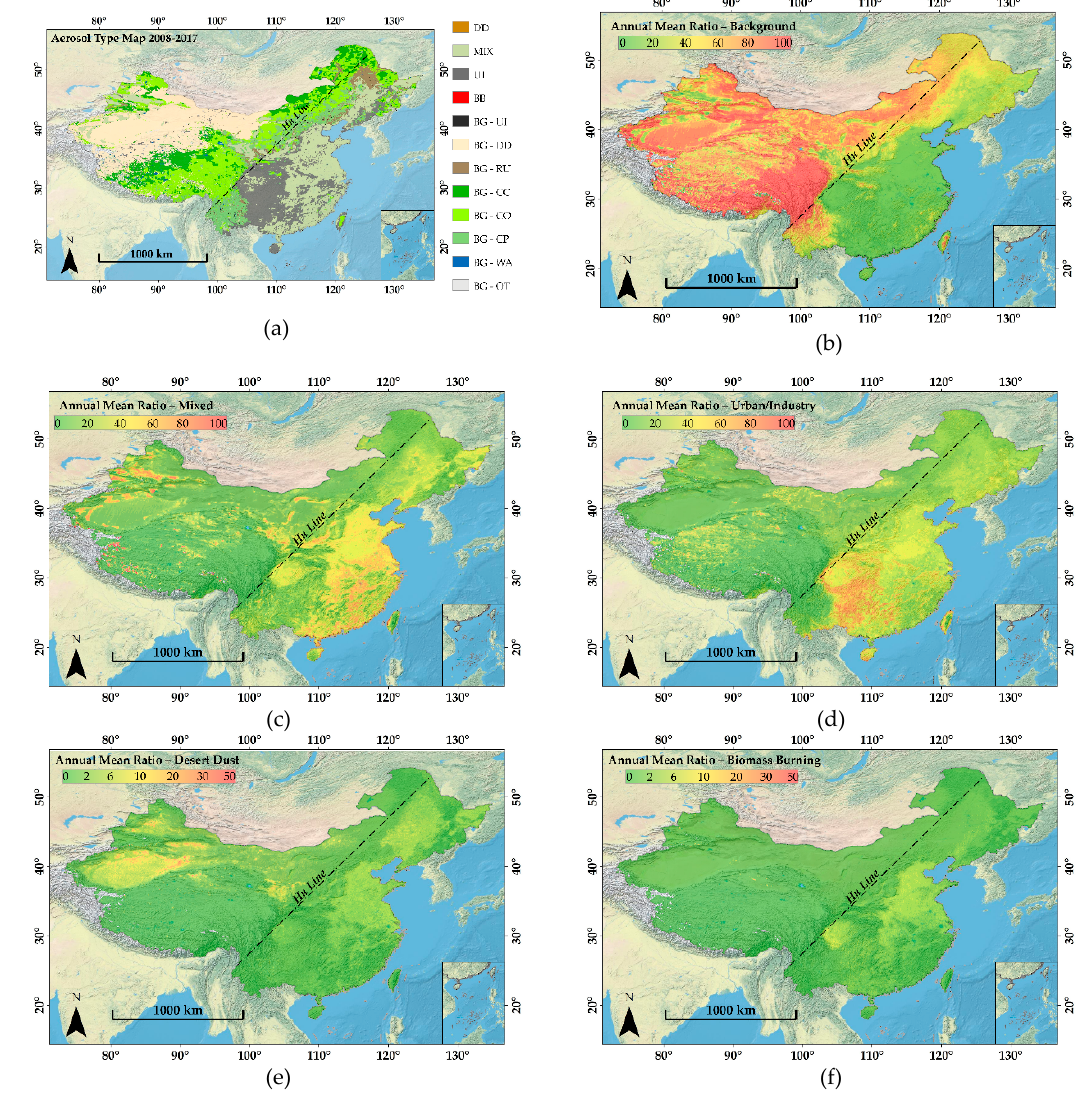
Figure 6. Spatial distribution of ( a ) the dominant aerosol types and the annual mean ratios of ( b ) background, ( c ) mixed, ( d ) urban/industry, ( e ) desert dust, and ( f ) biomass burning aerosols over China from 2008 to 2017.